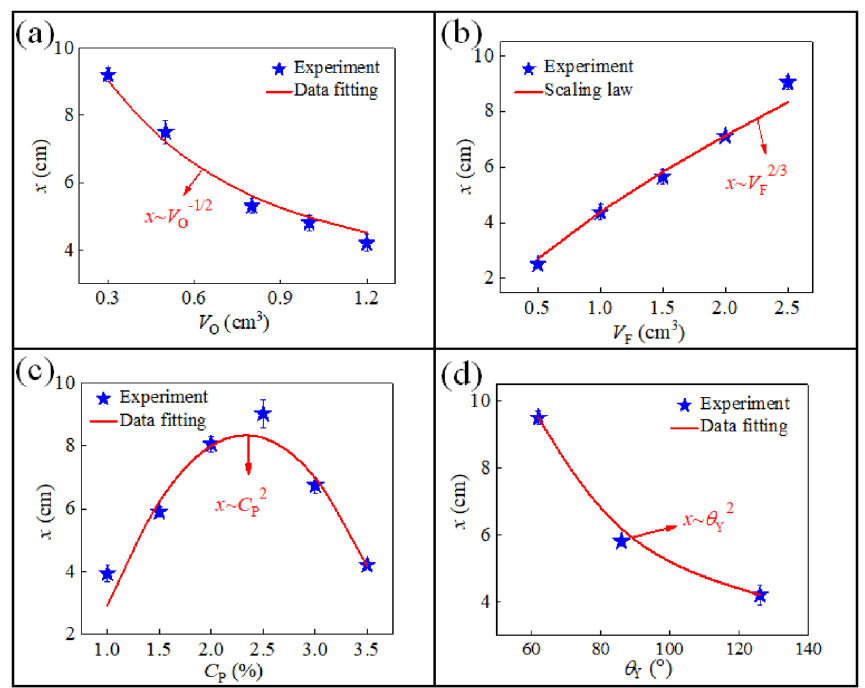
Figure 5. Dependence relationship between the maximum displacement x and various parameters, i.e. ( a ) the volume of the oil drop V O , ( b ) the volume of the foam V F , ( c ) the concentration of the magnetic particles C P , and ( d ) the Young’s contact angle θ Y